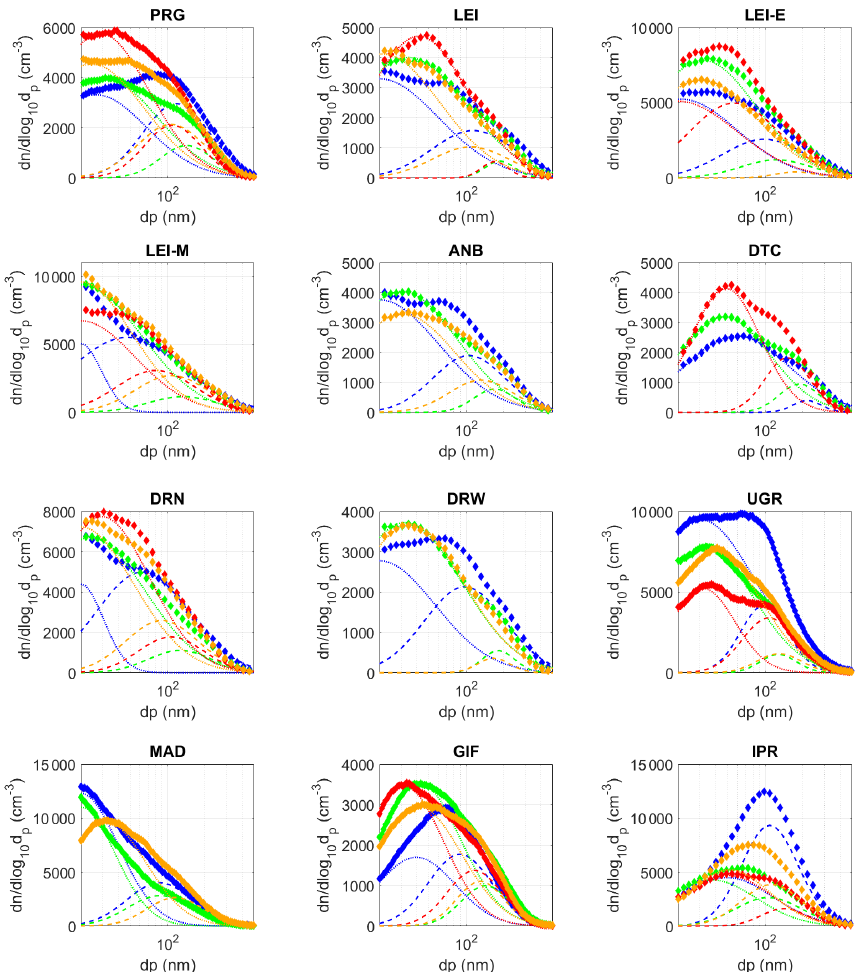
Figure A2. Median particle size distributions (diamonds) and corresponding modes (dotted lines) at urban continental sites. See Fig. A1 for an explanation of the